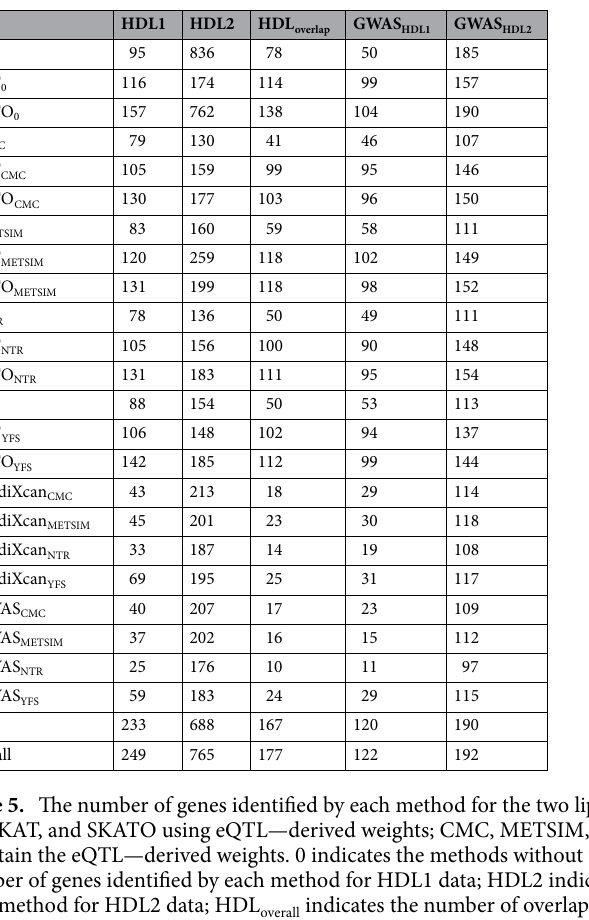
of 13 genes identified only by Overall based on HDL1 data have been reported, and one out of 6 genes has been reported on HDL2 data in the GWAS catalog. We also use these two HDL GWAS data sets for partial validation by looking for the number of overlapping genes identified by both of the data sets (Table 5, HDL overlap ). There are 177 overlapping genes identified by Overall for both SCZ1 and SCZ2 data sets and 167 overlapping genes identi- fied by OT for both SCZ1 and SCZ2 data sets.